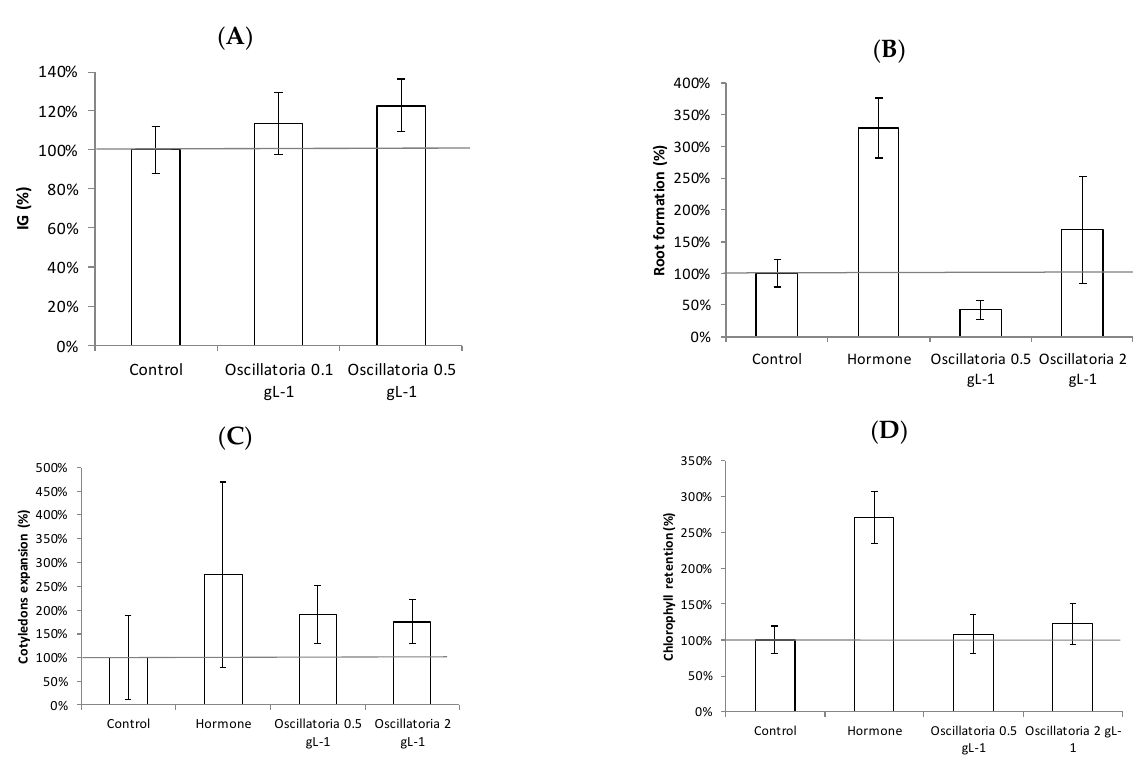
Figure 6. Germination index results: gibberellin-like effect in watercress seeds ( A ). Root formation results: auxin-like effect in mung beans ( B ). Cotyledon expansion results: cytokinin-like effect in cucumber seeds ( C ). Chlorophyll retention results: cytokinin-like effect in wheat seeds ( D ).